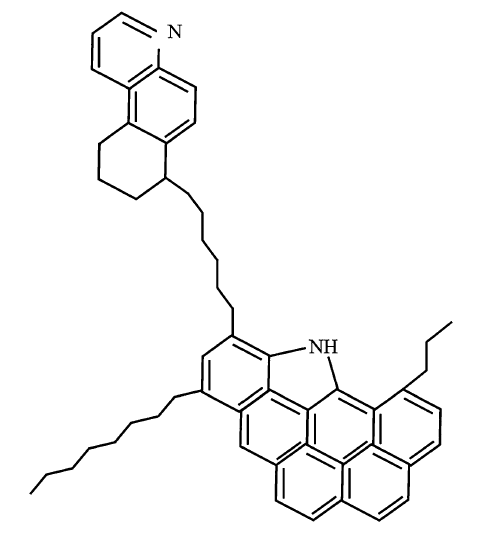
Fig. 6 Archipelago asphaltene structure (Alvarez-Ramirez and Ruiz- Morales 2003)